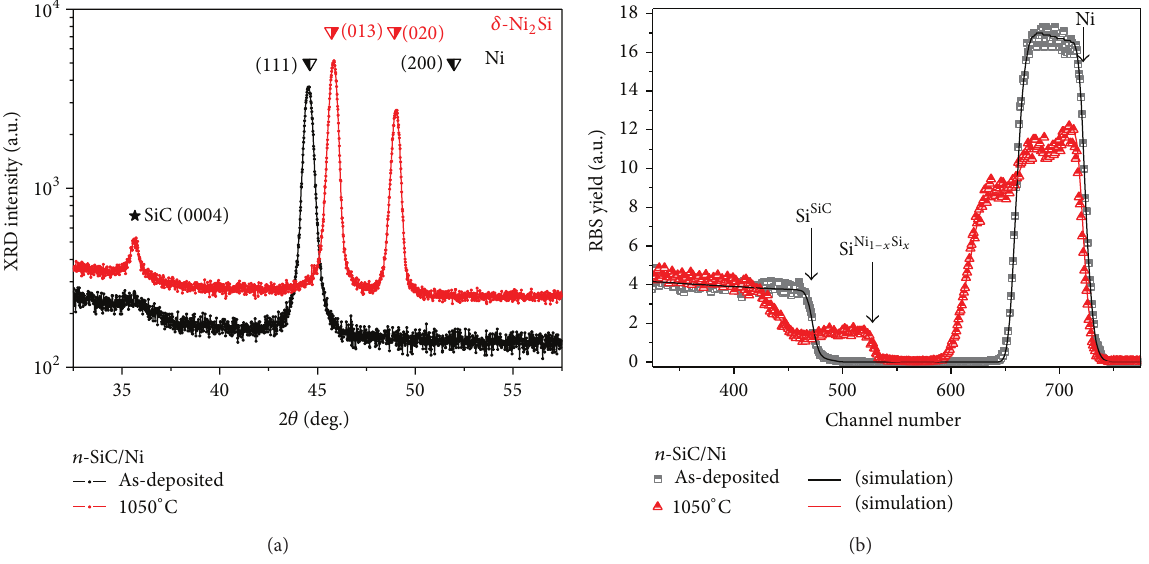
Figure 4: XRD (a) and RBS (b) spectra for as-deposited and annealed at 1050 ∘ C n -SiC/Ni (85 nm) contacts.